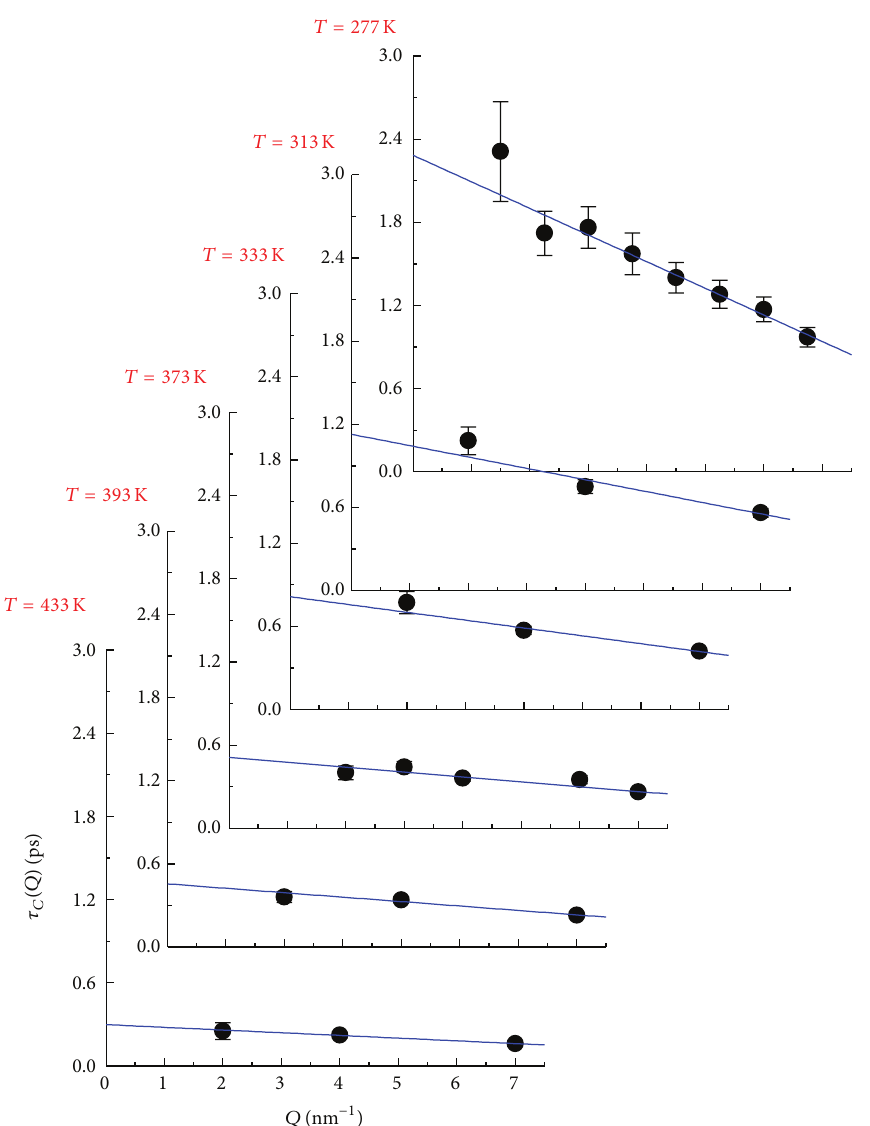
Figure 14: The 𝑄 -dependence of the relaxation timescale 𝜏 𝑐 (𝑄) is reported as derived from [13] at the temperatures indicated in the individual plots. The corresponding linear best fits used to extrapolate the 𝑄 = 0 limits are also reported for